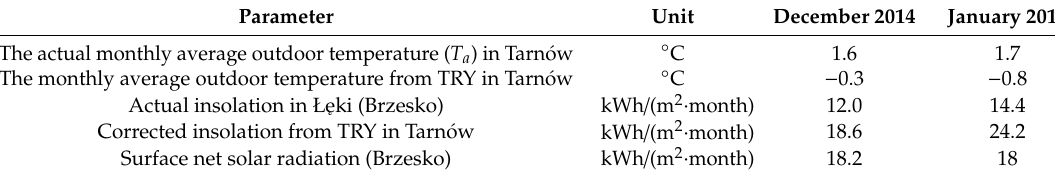
Table 5. Monthly insolation (Tarn ó w, Ł˛eki) and the monthly average outdoor temperature (Tarn ó w)